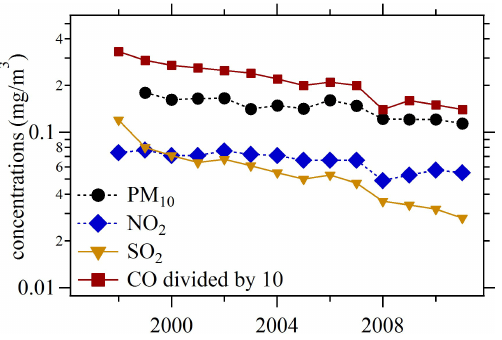
Figure 5. Variations of 24h averages of some primary pollutants (PM 10 , NO 2 , SO 2 , and CO) reported by the Beijing Municipal Bu- reau of Environment Protection between 1998 and 2011.